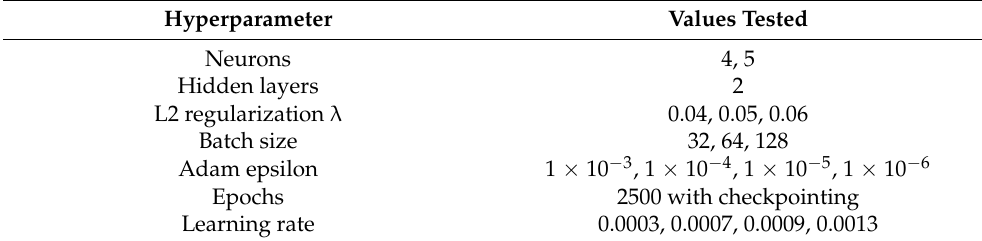
Table 2. Neural network model final hyperparameter search specifications.